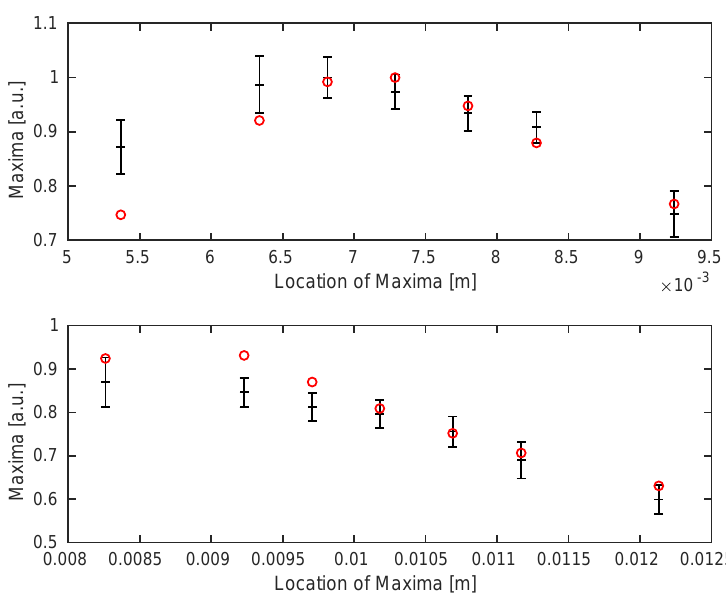
Figure 9. Comparison between averaged maximum values of the experimental data (black) and simulations (red) for different position through the focus after the recalibration of values w 0 and θ max . Top: we see the top surface, bottom: the background surface of the underlying coverglass. For a better visualization, in Figure 10, a direct comparison between experimental data and the simulations (using recalibrated system parameters) for a single A-scan is provided. In order to obtain a reasonable comparison, both experimental and simulated datasets are normalized to one.